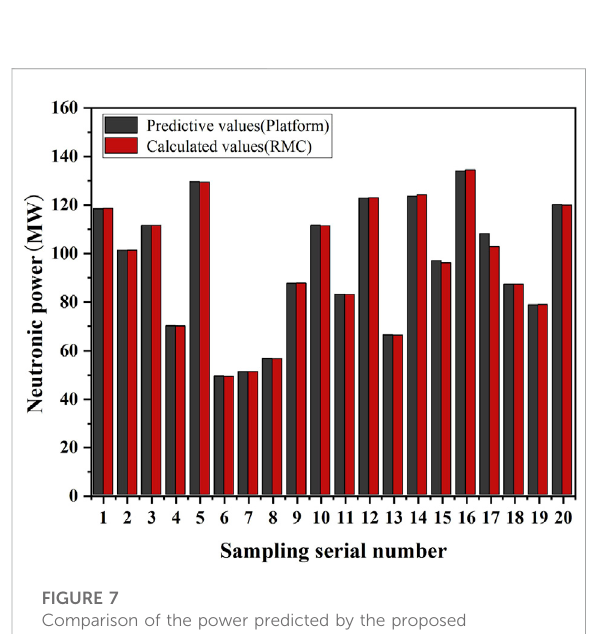
FIGURE 7 Comparison of the power predicted by the proposed platform with that predicted using RMC.